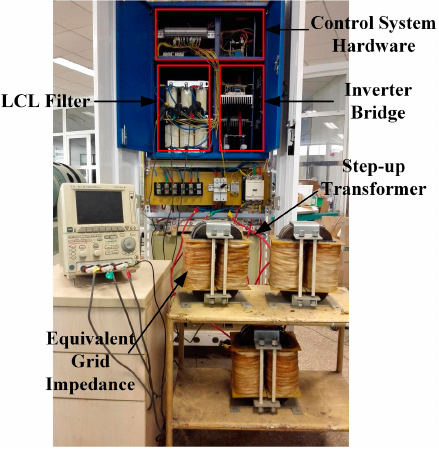
Figure 11. The experimental setup for the current control scheme test.